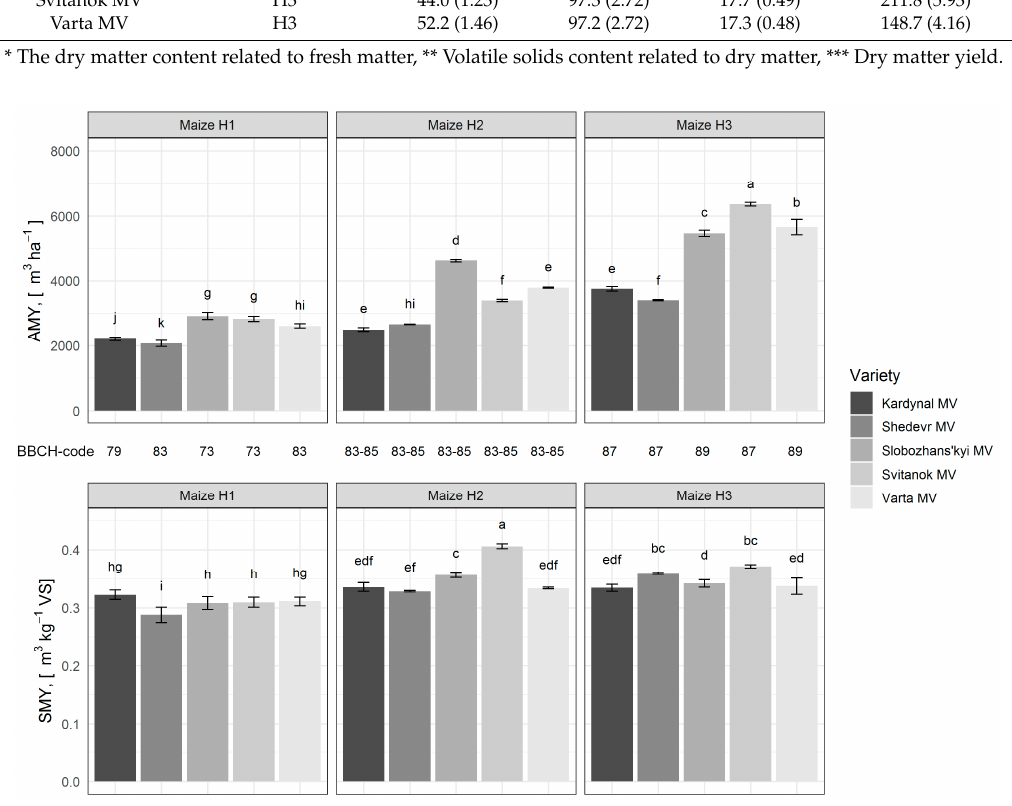
Figure 2. Specific methane yield (SMY) and areal methane yield (AMY) of the maize varieties harvested at H1, H2 and H3 harvesting times, which correspond to a certain BBCH-code related to a specific stage of crop phenological development. Histograms are charted based on the mean values; error bars indicate the variability between the three replications. Lower case letters indicate significant differences between all the maize samples according to the results of the Tukey test.